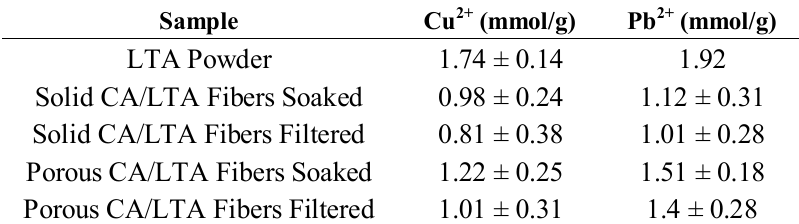
Table 1. Summary of ion exchange for LTA powder and CA/LTA fibers for Cu 2+ and Pb 2+